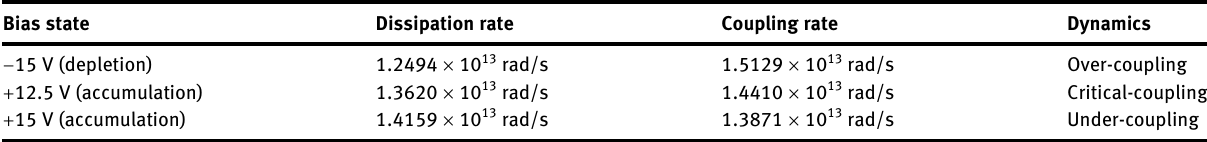
Table  : Dissipation and coupling rates of each bias state by using the coupled mode theory in [  ]. Bias state Dissipation rate Coupling rate Dynamics −  V